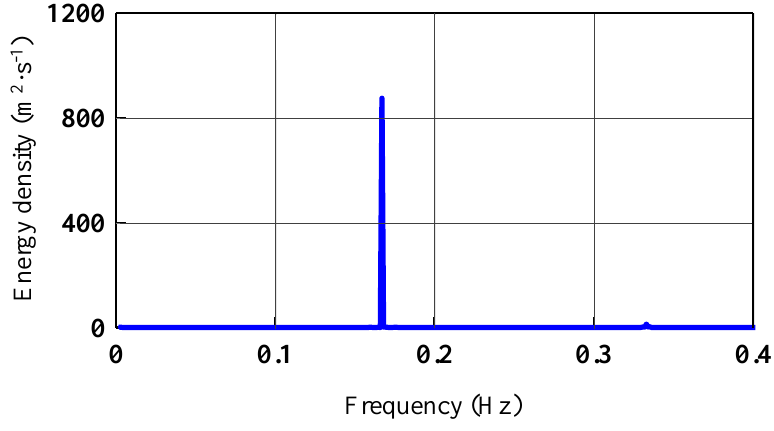
Figure 5. Vertical displacement spectrum (T = 6 s).